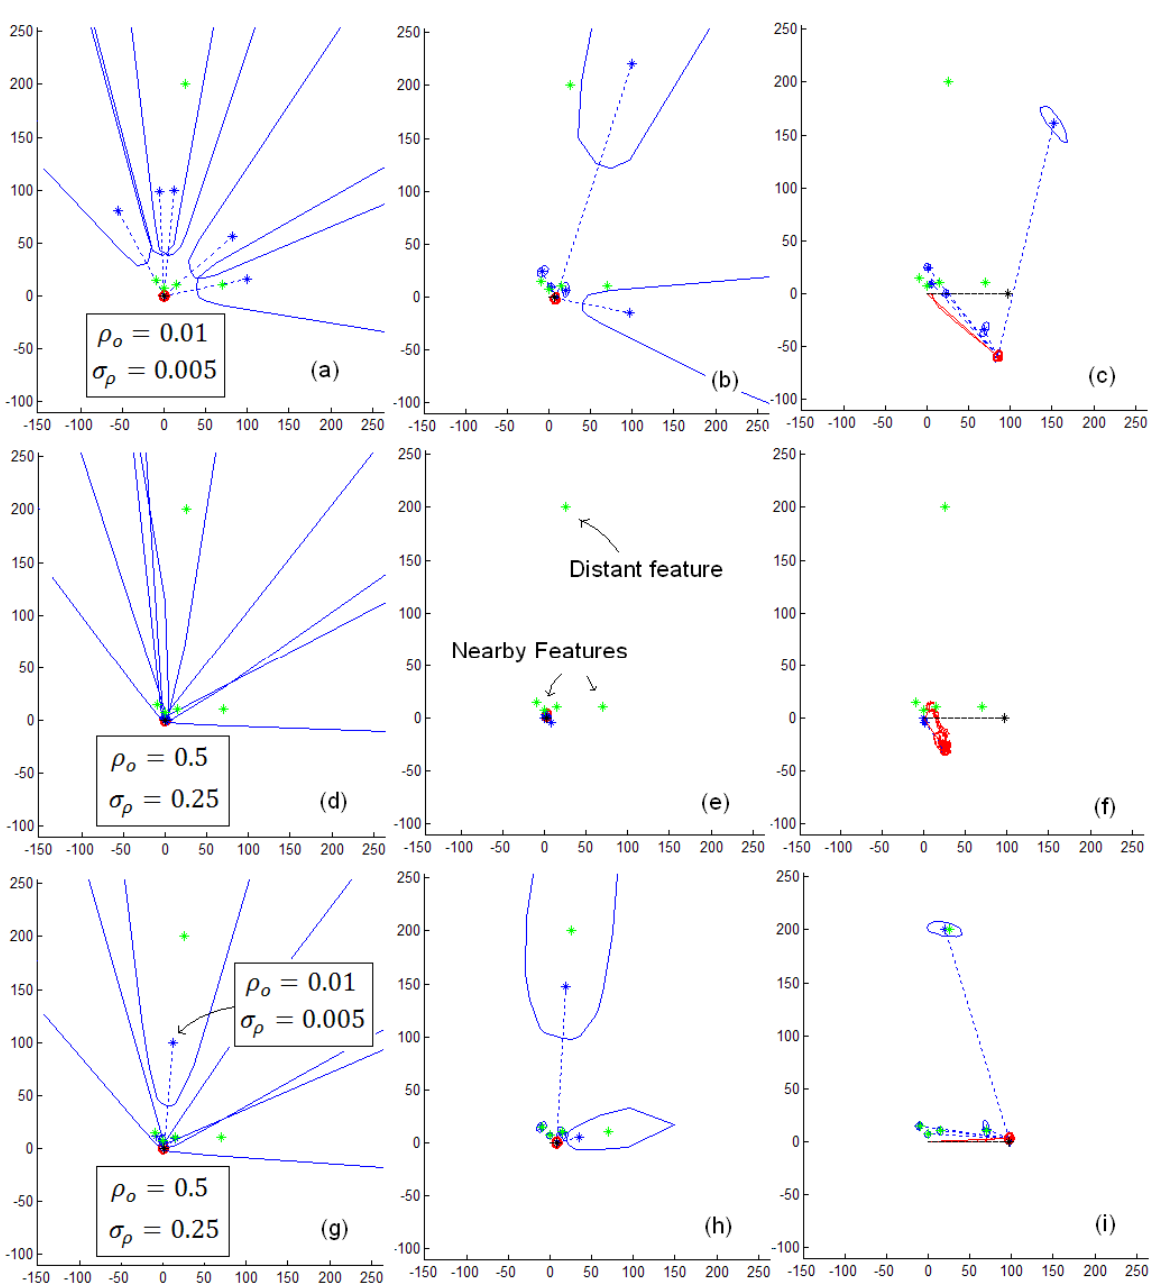
Figure 3. Some issues of the ID-Undelayed